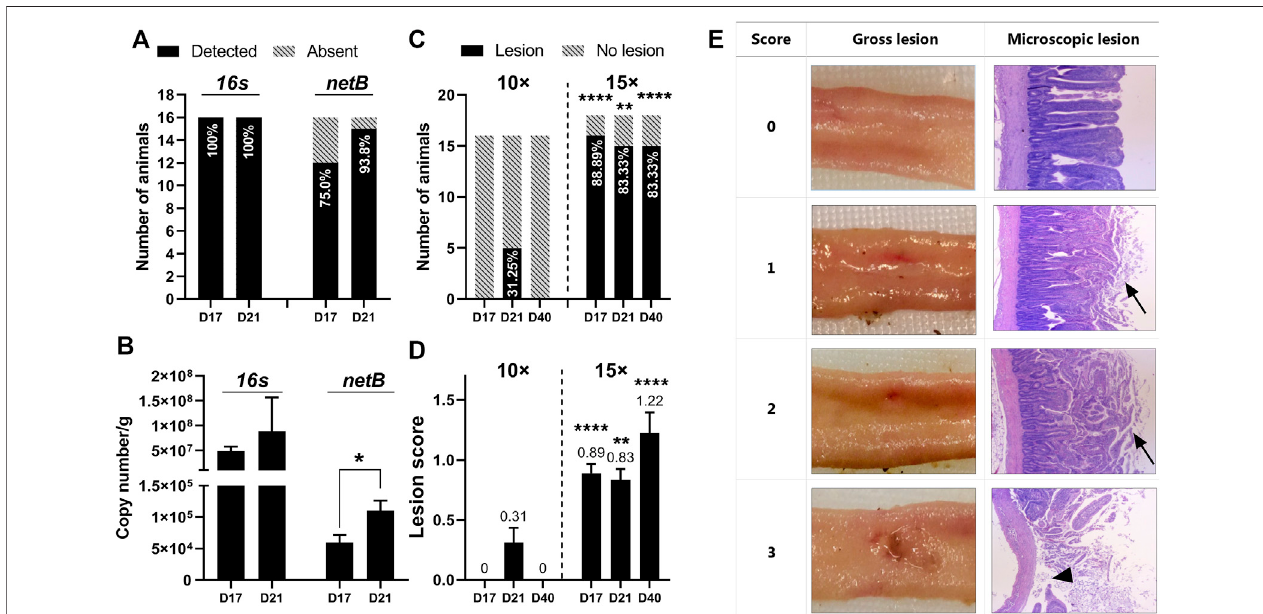
FIGURE3| Quanti fi cationof C perfringensandintestinelesioncon fi rmedinductionofsubclinicalnecroticenteritisusingthenaturalinfectionmodel (A) Detectionof Cperfringens 16sandnetBgeneincecalcontentsbyqRT-PCR.Thepercentagesofanimalsdetectedwith16sornetBareplottedwithinbars.Datawerecollectedfrom fl ock 1 ( n = 16) (B) Abundance of 16s and netB gene expressed as copy number/g of cecal content. Data were collected from fl ock 1. T-tests were conducted to compare gene abundance between the age of days 17 and 21. The netB abundance on day 21 was signi fi cantly higher than on day 17 ( p = 0.0242) (C) Intestine gross lesion prevalence in fl ock 1 (challenged with 10× concentrated coccidial vaccine) and fl ock 2 (challenged with 15× concentrate/d coccidial vaccine). The percentagesofanimalsdetectedwithgrosslesionsareplottedwithinbars.Fisher ’ sexacttestwasconductedtocomparethedifferencebetweenlowandhighcoccidial challenged animals (D17: p < 0.0001, D21: p = 0.0045; D40: p < 0.0001) (D) Lesion scoring results from fl ock 1 and fl ock 2. A nonparametric Mann-Whitney test was used tocompare the rankoflesion scorebetweentwococcidialchallenge levels from thesame age (D17: p < 0.0001, D21: p =0.0045,D40: p < 0.0001) (E) Severityof NE-speci fi c lesions was scored from 0 to 3 based on the intestine gross examination. The tissue at the lesion site was processed for the histology analysis. The original magni fi cation of theimages is×25. The necrotic tissuewastypicallycovered by alayer ofmixed cellular debris(arrow). Sloughed mucosa leading tocomplete loss ofvilli (arrowhead) was observed in intestinal tissue with a score of